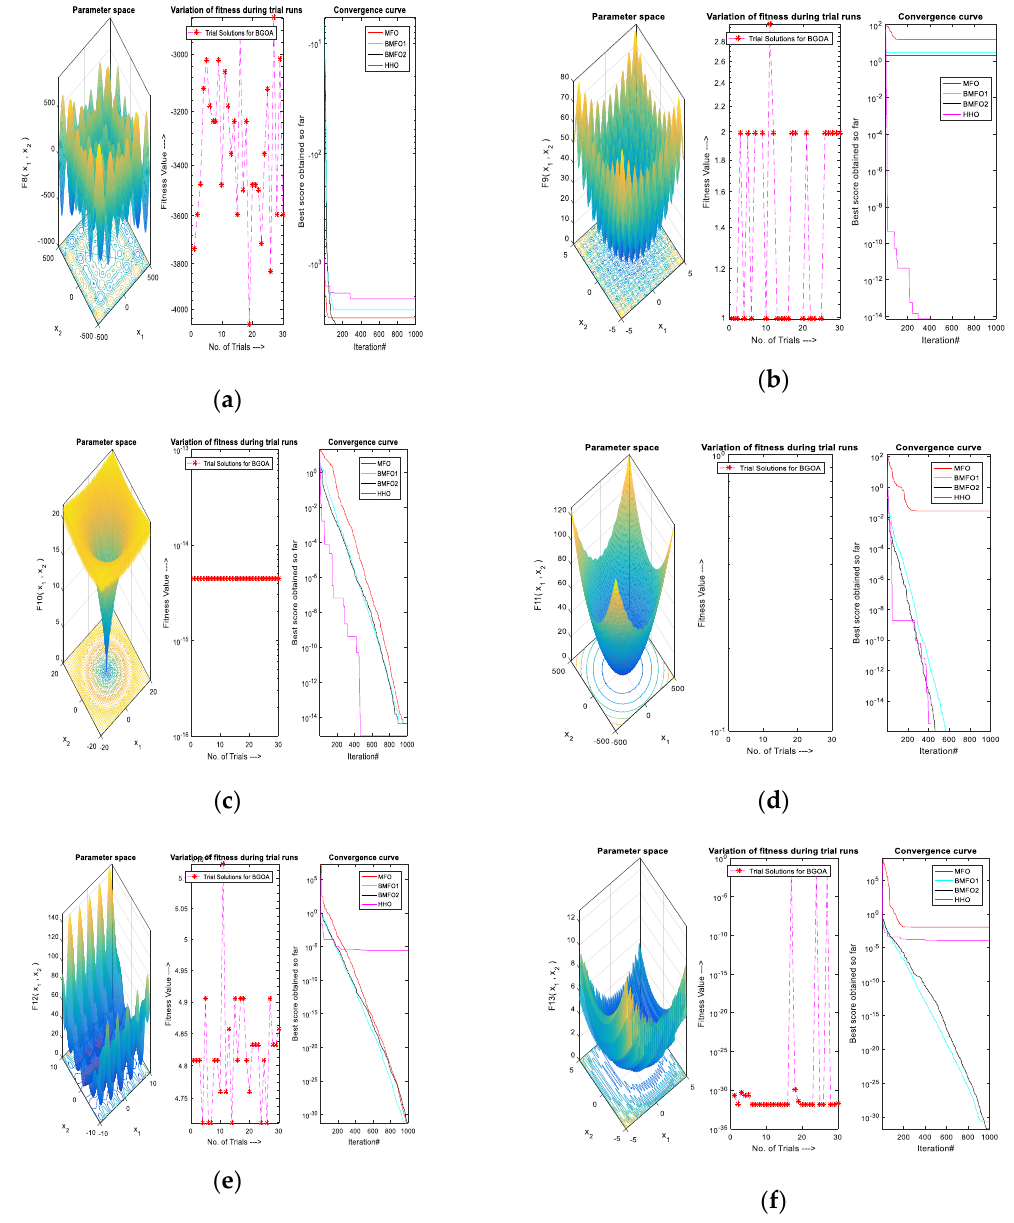
Figure 6. ( a – f ) Convergence curve of all algorithms for multi-modal benchmark Figure 6. ( a – f ). Convergence curve of all algorithms for multi-modal benchmark functions.